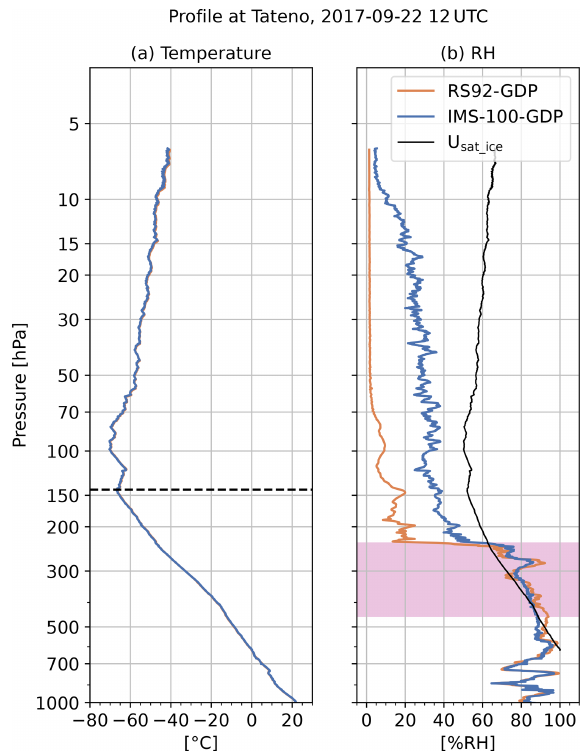
Figure 11. Temperature (a) and RH (b) profiles for RS92-GDP (orange) and iMS-100-GDP (blue) at 12:00UTC on 22 September 2017. The dashed line in panel (a) represents tropopause pressure. The black line in panel (b) shows the RH profile for ice-saturated air with iMS-100-GDP temperature; air is supersaturated for ice if the observed RH exceeds this value. The pink shaded layer (453.2– 232.4hPa) shows the ISSR for